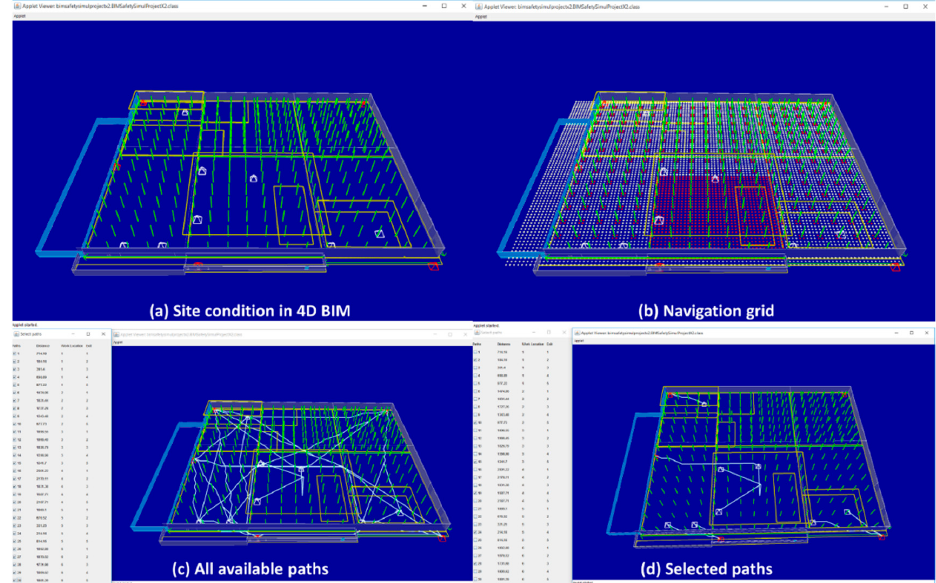
Figure 18. Scenario 4 ( a ) site condition, ( b ) navigation grid, ( c ) all available paths, and ( d ) selected paths. 5.4. Step 5: Distribute Selected Paths to Crews After generating all the evacuation paths of the four project milestones, certain evaluation paths were selected based on the project-specific review as discussed in Section 5.3. The research team provided information on the selected evacuation paths to the general contractor for distribution to the work crews of the project. Although there was no incident of safety hazards that required evacuation from the construction site, the general contractor was able to provide evacuation paths that were generated based on BIM containing up-to-date project status as well as construction site